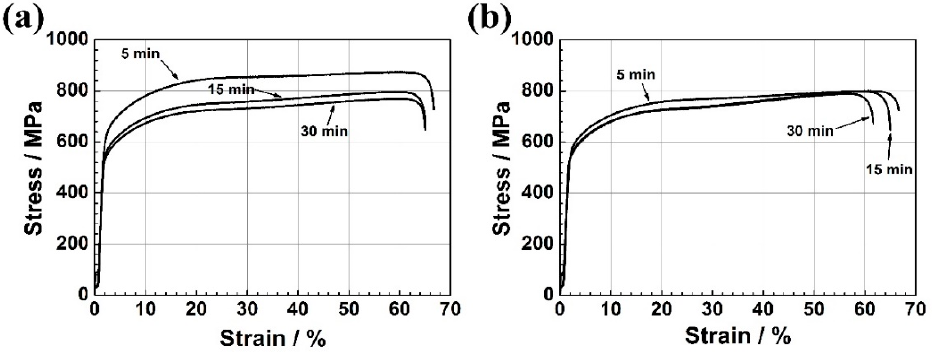
Figure 3. Stress–strain curves of Cr19 series DSS after solution treatment at 1050 °C for 5 to 30 min, ( a ) Cr19, and ( b ) Cr19 + W DSS. Table 3. Tensile test results of Cr19 series DSS after solution treatment at1050 °C for 5 to 30min.